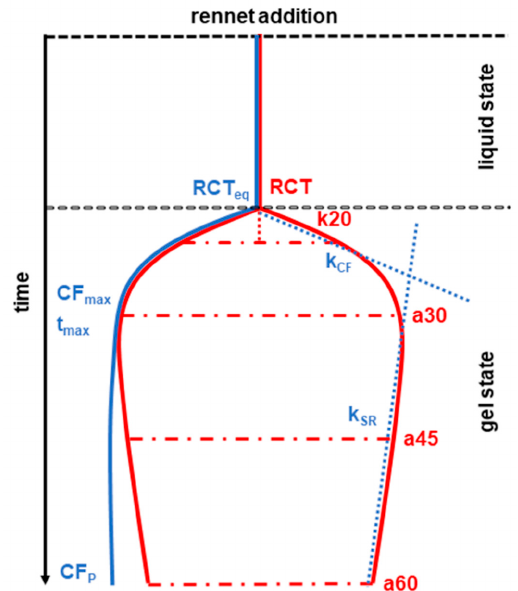
Figure 1. Graphic representation of milk coagulation traits based on the papers and illustrations by McMahon and Brown [8], Bittante [9], and Bittante et al. [10,11]. Traditional or single-point milk coagulation properties (MCPs) are reported in red: The rennet coagulation time (RCT) (measured in min) is i.e.,the interval between rennet addition and coagulation; k20, curd firming time (min), the interval between milk coagulation, and a width of 20 mm of the bell diagram; a30, a45, and a60, curd firmness (mm), the width of the bell diagram at 30, 45, and 60 min after rennet addition. Modeled curd firming over time (CF t ) traits are in blue: Rennet coagulation time estimated by the CF t equation (min) (RCT eq ); the maximum potential curd firmness after an infinite time (mm) (CF P ); curd-firming rate constant (% × min − 1 ) (k CF ), the higher the value, the faster the curd firming; syneresis rate constant (% × min − 1 ) (k SR ), the higher the value, the stronger the syneresis force; maximum curd firmness (mm) (CF max ); time to attain CF max (min) (t max